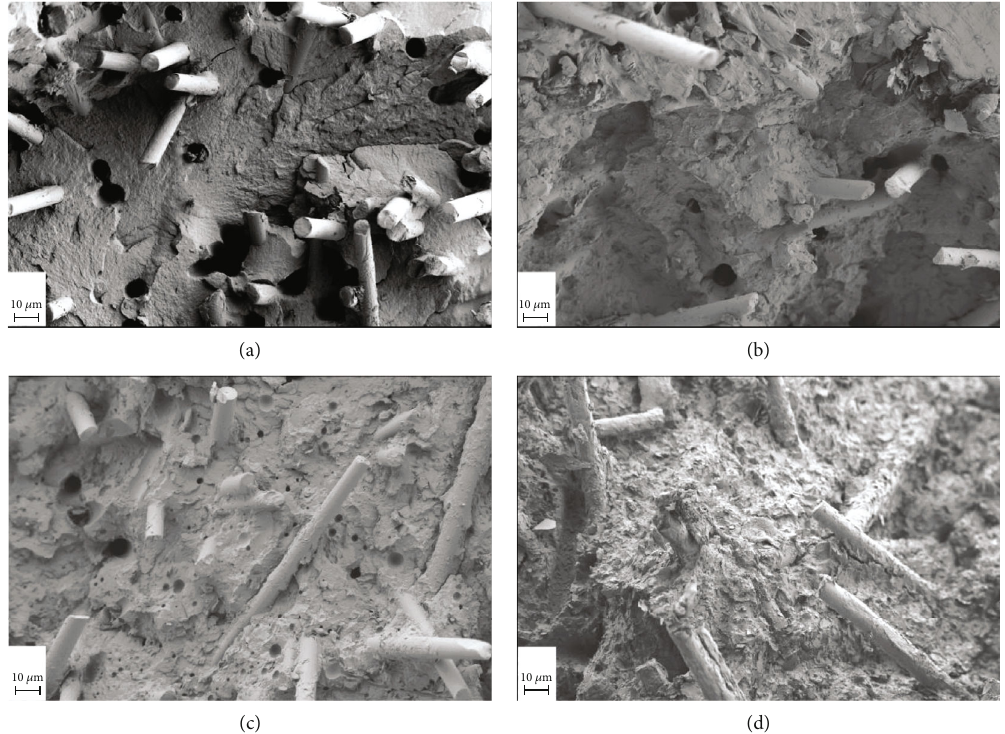
Figure 4: SEM micrograph of PA6/GF (a) and composite with 10 wt% EG1000 (b), 2% EG5 (c), and 10% EG5 (d). Magni fi cation